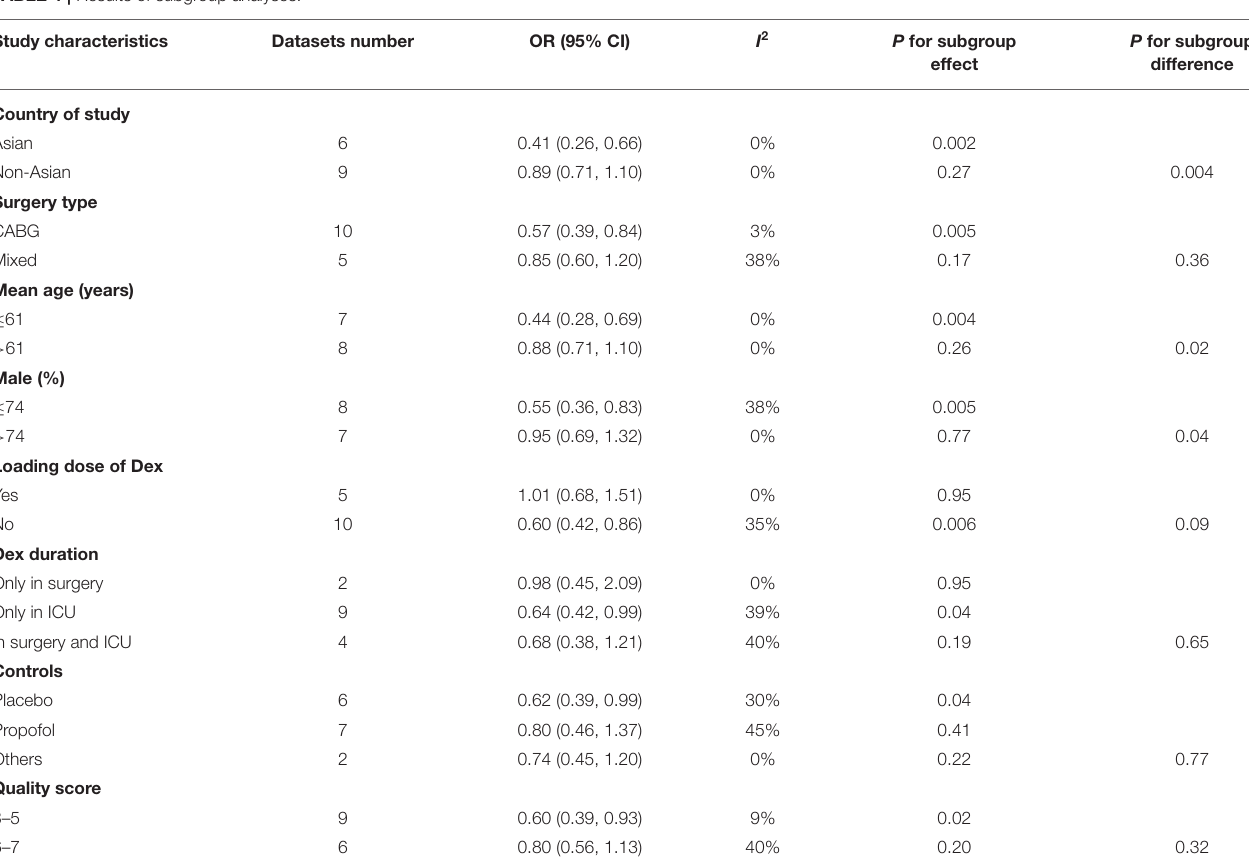
TABLE 4 | Results of subgroup